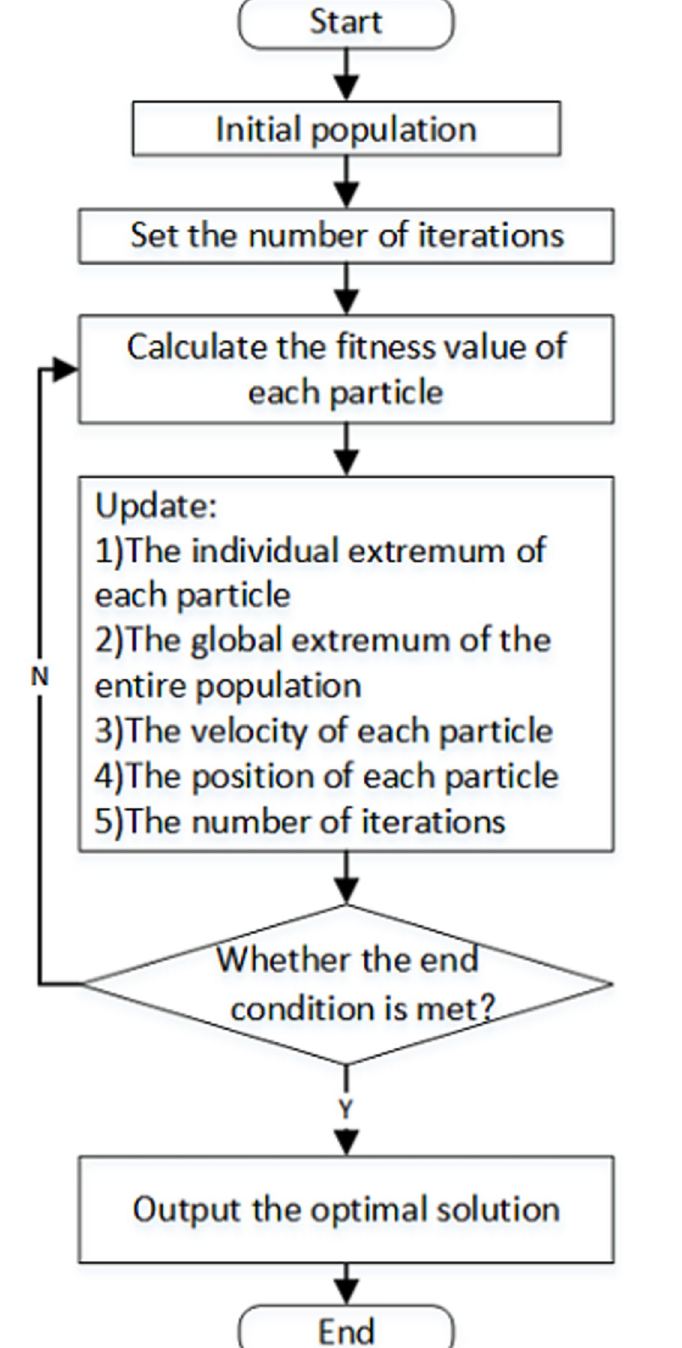
Fig 2. Flow chart of the particle swarm optimization.